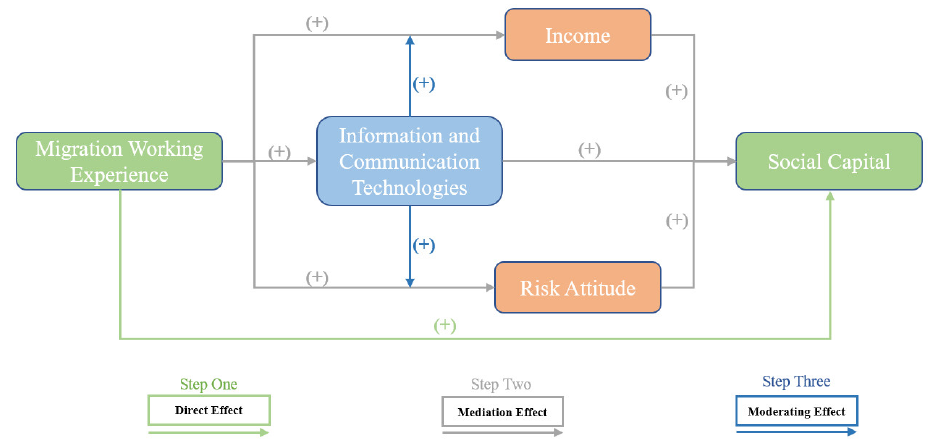
Figure 1. The influence mechanism of MWE on SC.